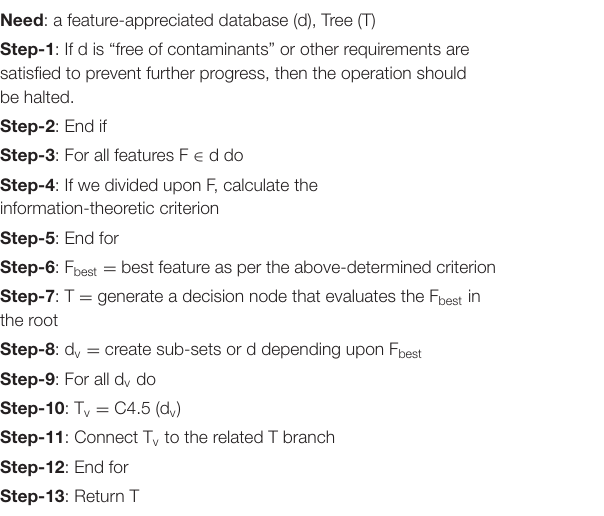
Algorithm 2 : | Procedure of